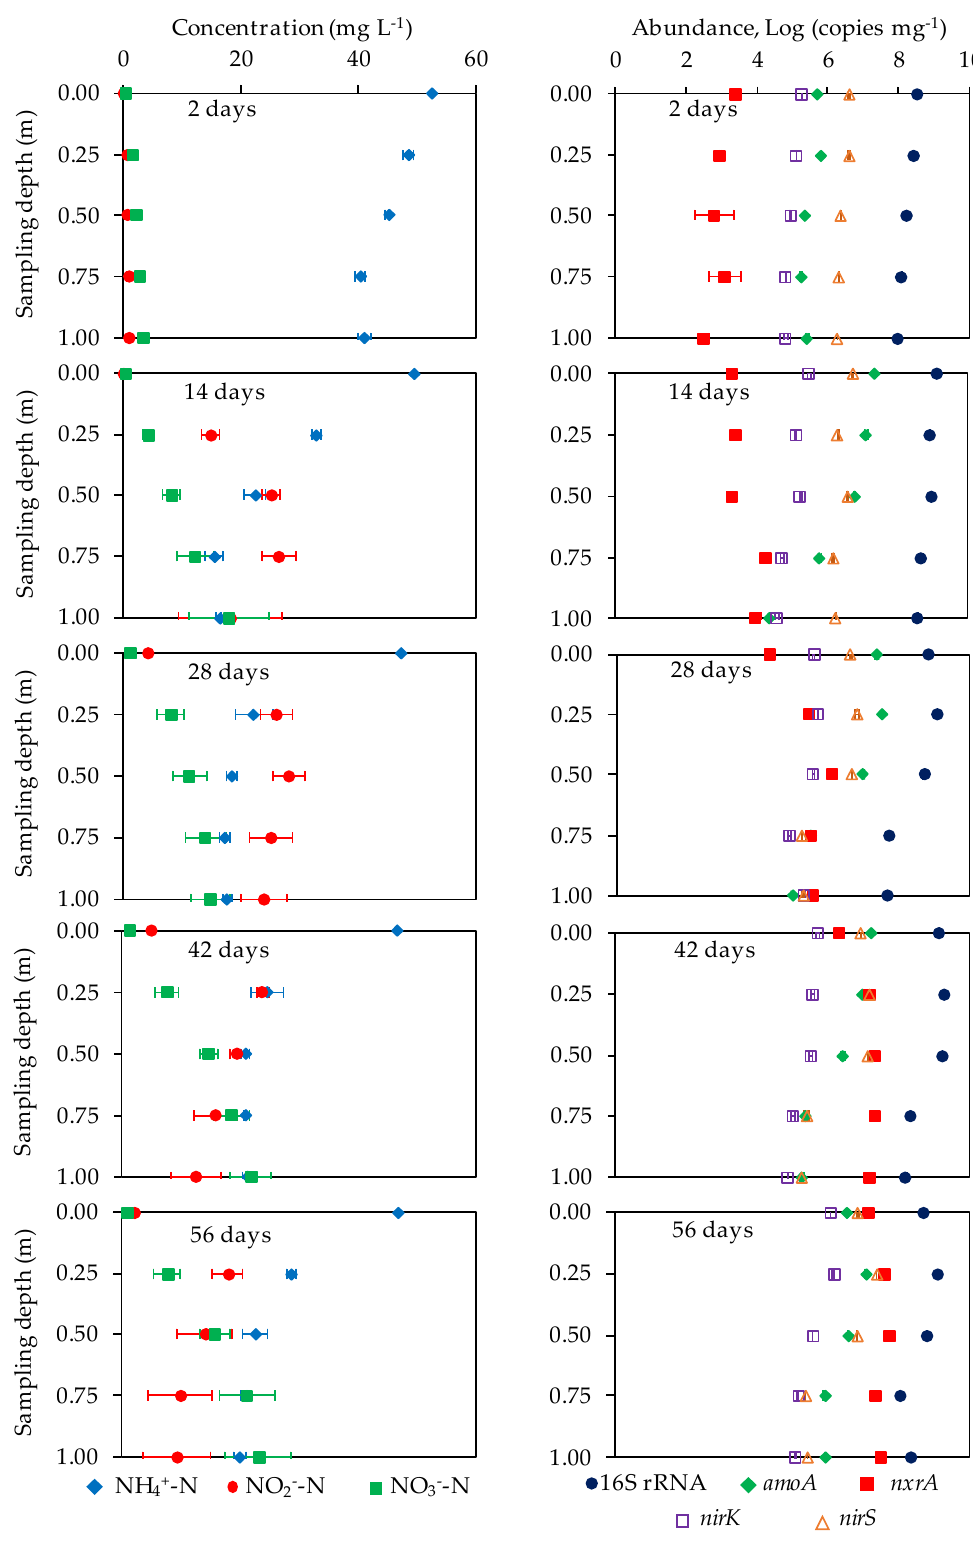
Figure 4. Profiles of NH 4 + -N, NO 2 − -N, NO 3 − -N, and functional genes along the single axis of the dropping flow every 2 weeks. NH 4 + -N, NO 2 − -N, and NO 3 − -N concentrations indicated are the averages ± SD of four replicate reactors. The gene copies shown represent the averages ± SD of duplicate experiments.